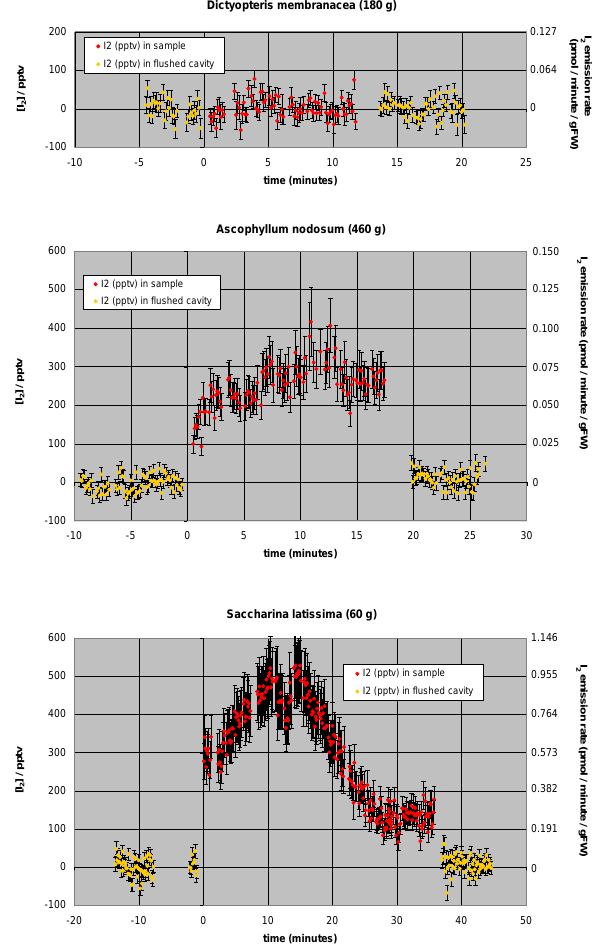
Fig. 3. Time series of the I 2 mixing ratios (left axis) and corresponding I 2 emission rates (right axis) observed in the incubation experiments on Dictyopteris membranacea (top), Ascophyllum nodosum (middle) and a young, healthy Sacharrina latissima plant (bottom).